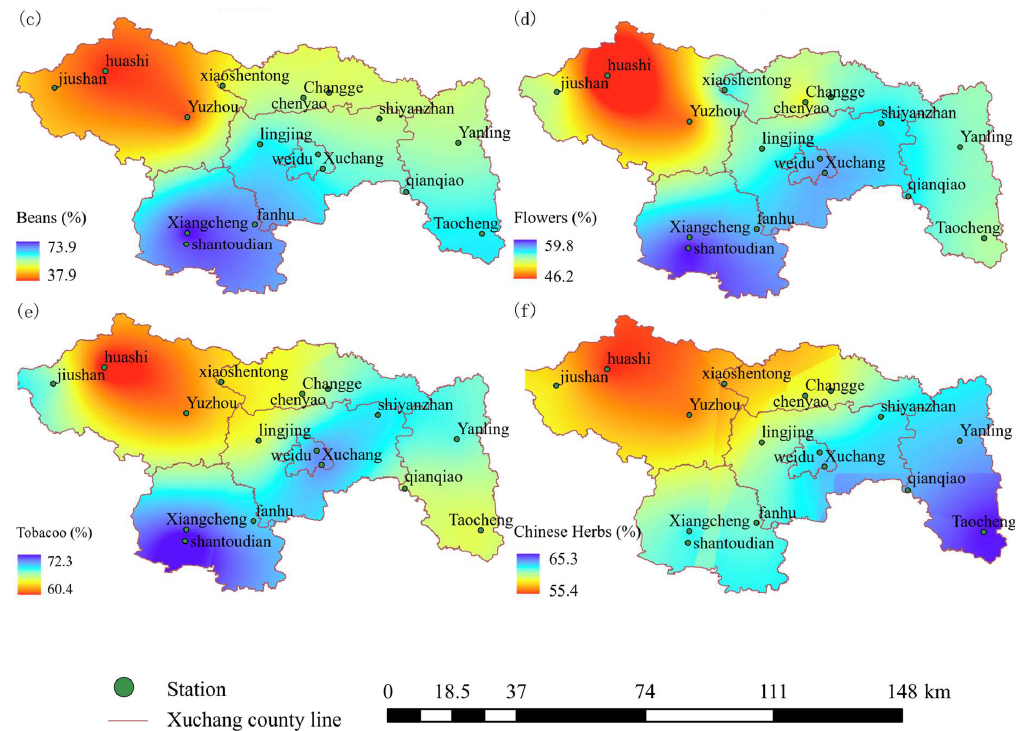
Figure 4. Spatial precipitation coupling degree analysis of main crops during crop growing period, ( a – f ) represent the coupling degree (%) of wheat, maize, beans, flowers, tobacco and Chinese herbs, respectively.